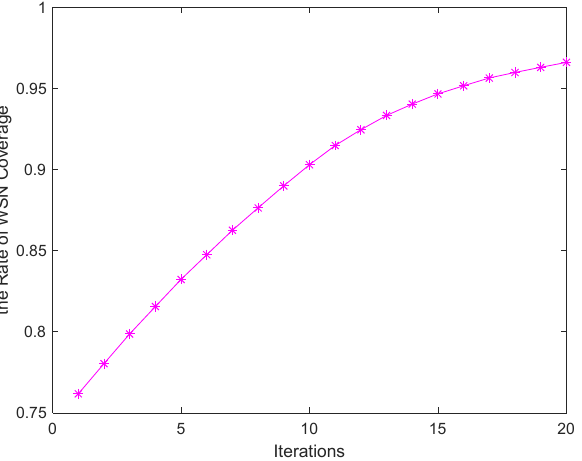
Figure 11. Coverage curve of the 3D-IVFC algorithm for the 3D surface issue.